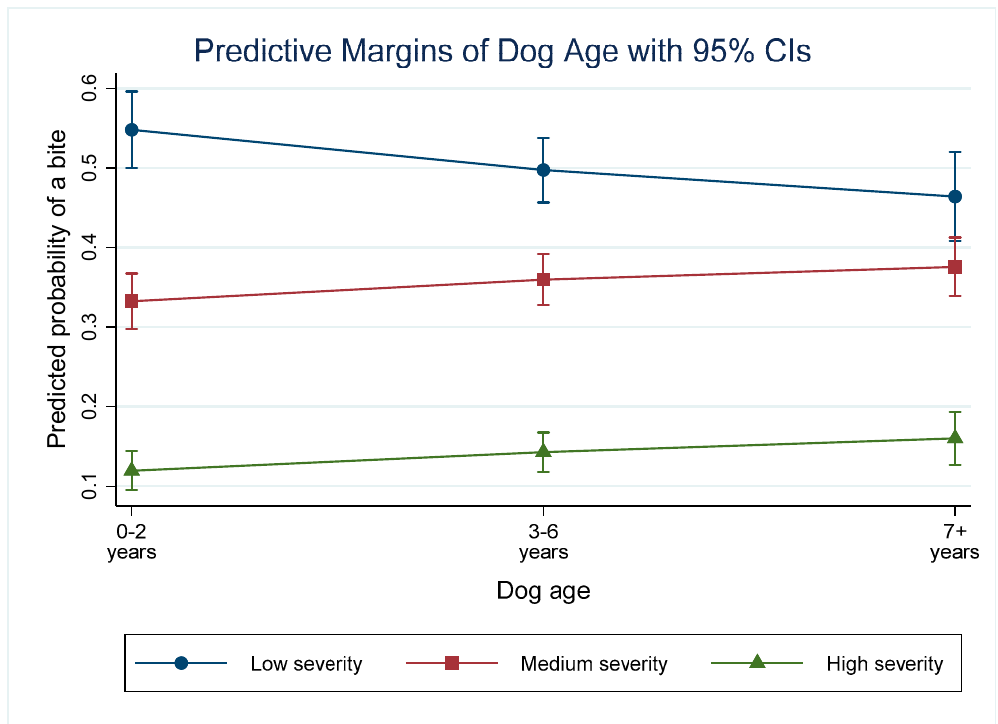
Figure 5. Predictive margins for the different severity incidents depending on the victim age category and controlling for other variables in the model.